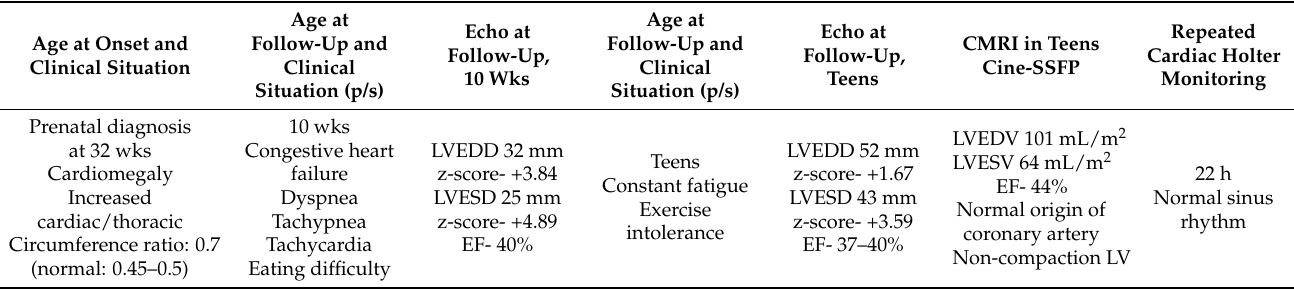
Table 1. Clinical evaluation of the DCM